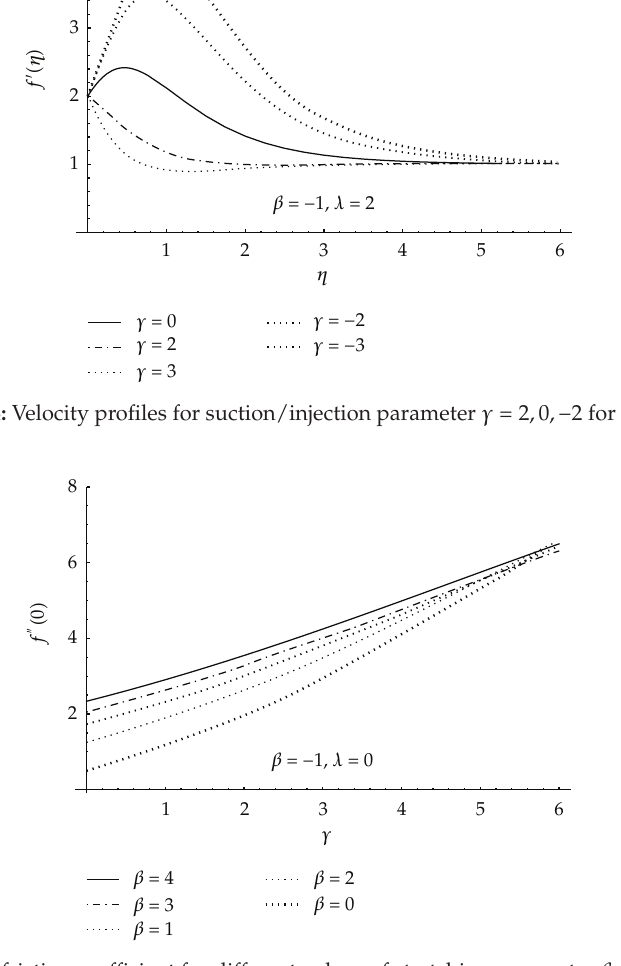
Figure 5: Skin friction coe ffi cient for di ff erent values of stretching parameter β (cid:8) 4 , 3 , 2 , 1 , 0.